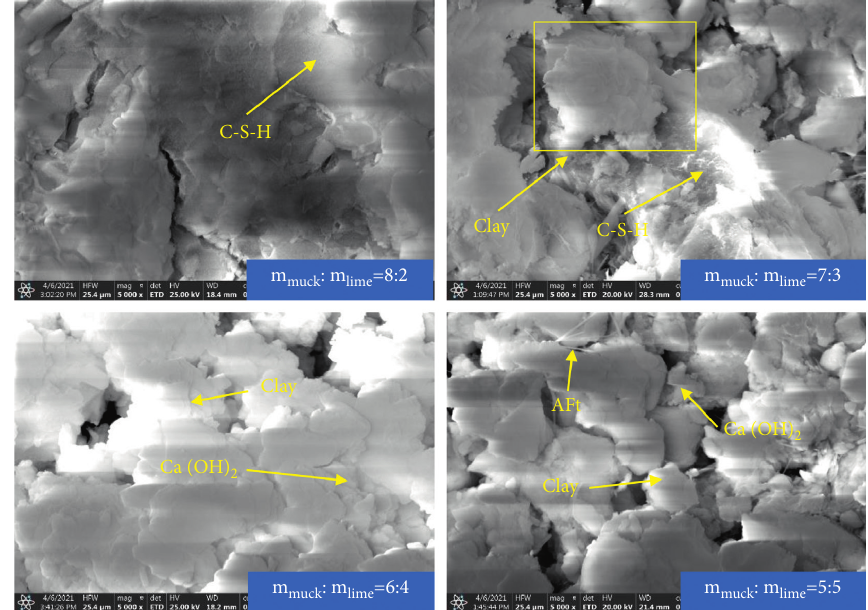
Figure 10: SEM images of nonsintered bricks with different lime doping